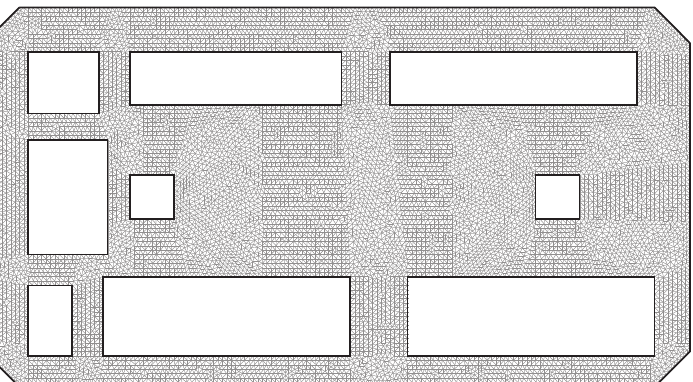
Figure 2. Example of a finite element mesh for the computational domain Ω h used in the optimization